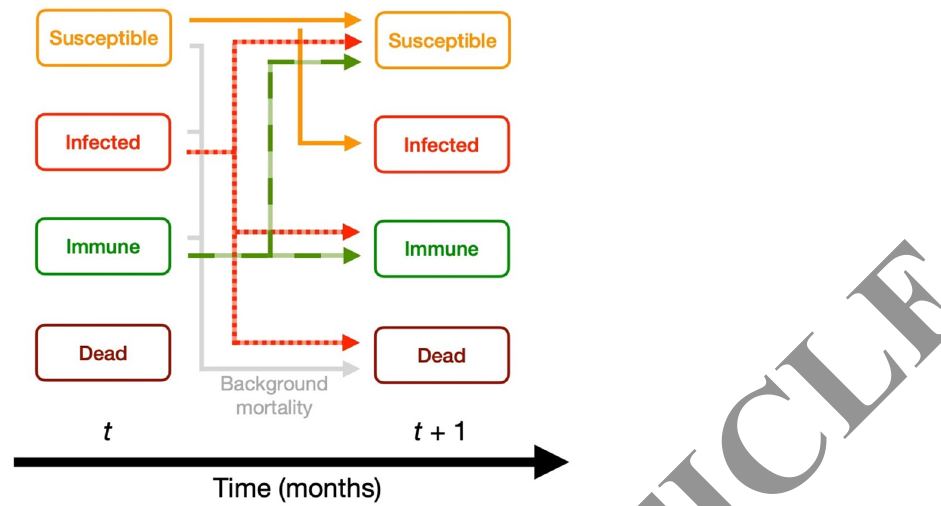
Figure 1. Conceptual epidemiological model applied to the study subpopulation. The time units are half months, and each stage (susceptible, infected, immune, dead) is fully age-dependent. The background mortality follows the sex-age-specific mortality estimated on the last 40 years of demographic information of the study population.